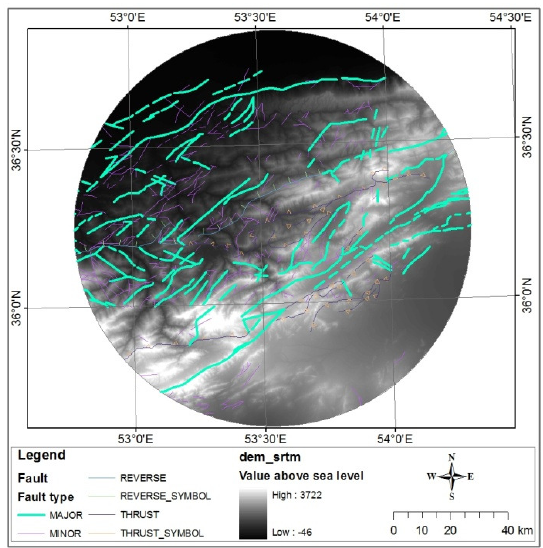
Figure 5: topographical terrain of the study area from SRTM data Although we have not considered some possible interfering controls in this study, this method using thermal remotely sensed data can be applied to identify the active areas of earthquake. Results of interpolation indicate that the pixels with higher values of magnitude are over the pixels with higher LST values. According to the pixel values it can be observed that in the far west end of the study area where the thermal values are the highest, the values of earthquake magnitude are also the highest. Thus, seismic active areas have excess infrared intensity in a long time before seismic activity (Saraf et al., 2009) and in this period the area may represent higher LST values. In a portion in the north of the area covered by a water body (Gorgan Bay), the magnitude raster represents high values while the thermal is low in value and this can be because of the moderating factor of water. There can be somewhat higher LST values along the line Khazar Major Fault in the northern part of the study area and also along Alborz Shomali Fault in the southern of the study area (refer to Figure 2). Saraf et al., (2009) also found that the LST increases in tectonic contact-faced areas. Therefore, we can see higher land surface temperature in areas along the fault lines (Ma et al., 2010) and over more active seismic